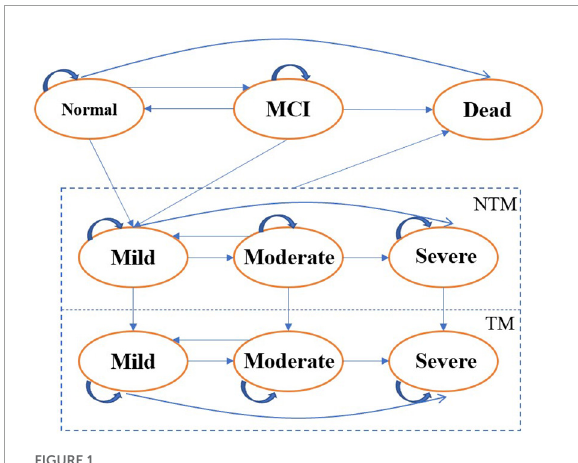
FIGURE1 Markov model. NTM, not taking medicine; TM, taking